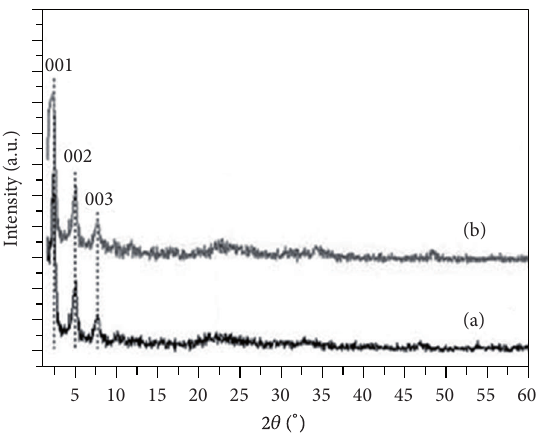
F 1: XRD patterns of VONTs (a) and Mo-doped VONTs [9] (b).